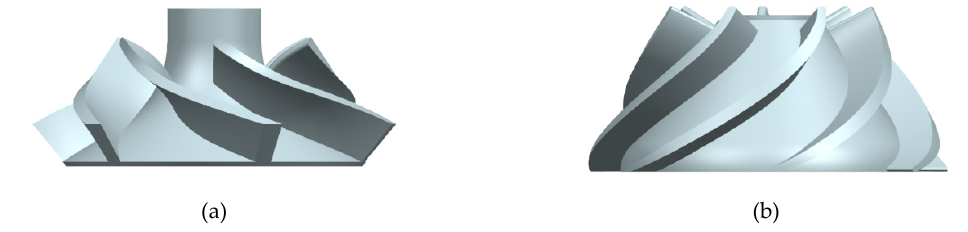
Figure 2. Solid model of impeller and diffuser. ( a ) Impeller, ( b ) diffuser.